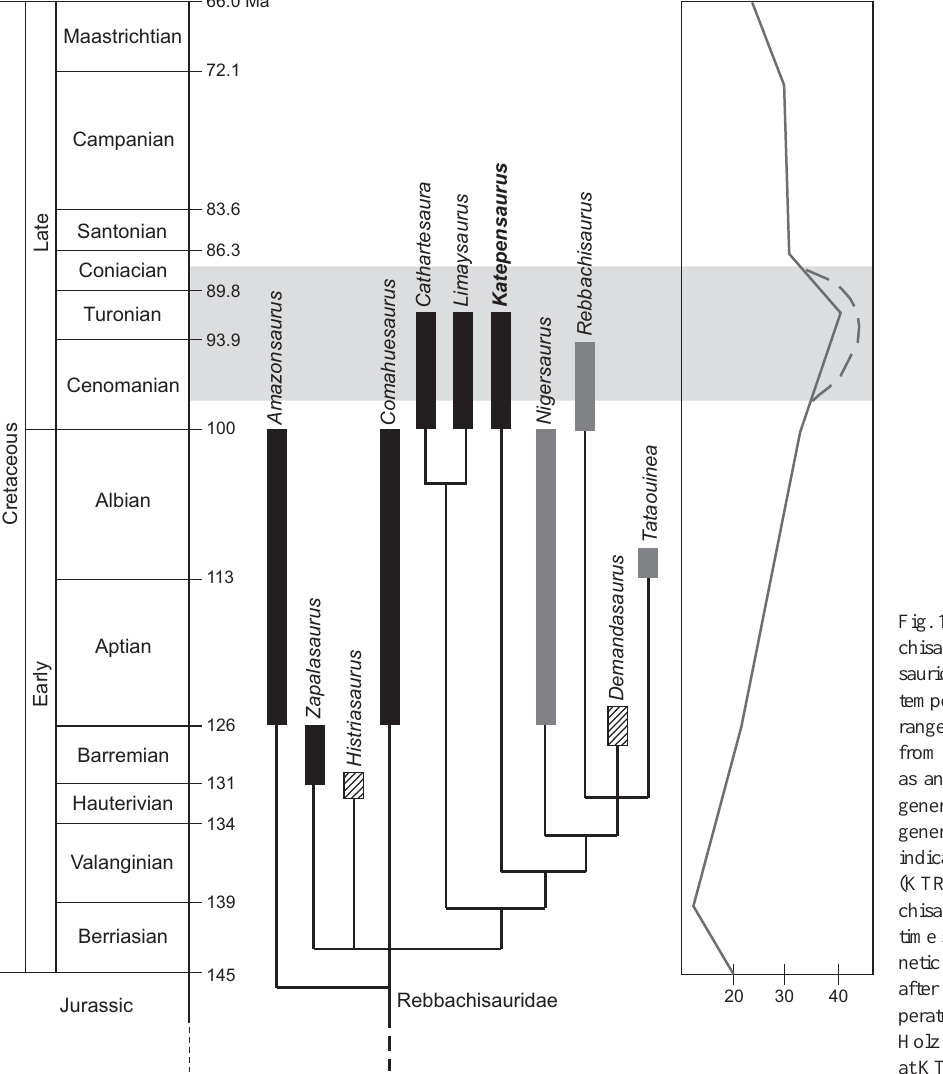
Fig. 10. Time-calibrated phylogeny of Rebba- chi sauridae and the relationship of rebbachi- saurid evolution to Mesozoic geography and temperature. Genera with hatched stratigraphic ranges are European (although Histriasaurus , from Croatia, is more appropriately regarded as an African taxon; see Ibiricu et al. 2015), genera in solid black are South American, and genera in gray are African. Light gray band indicates the Cretaceous Thermal Maximum (KTR); note the existence of multiple rebba- chisaurid genera during this interval. Geologic time scale after Walker et al. (2012); phyloge- netic topology and stratigraphic ranges of taxa after Fanti et al. (2015: fig. 21b); paleotem- perature curve based on and simplified from Holz (2015: appendix 1); curved, dashed line at KTR based on Zhou et al.